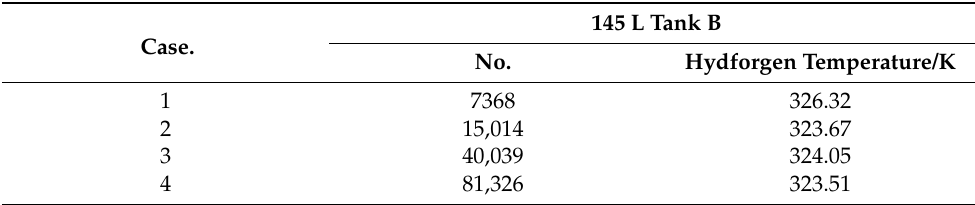
Table 2. CFD results of the mesh independence check. Case.